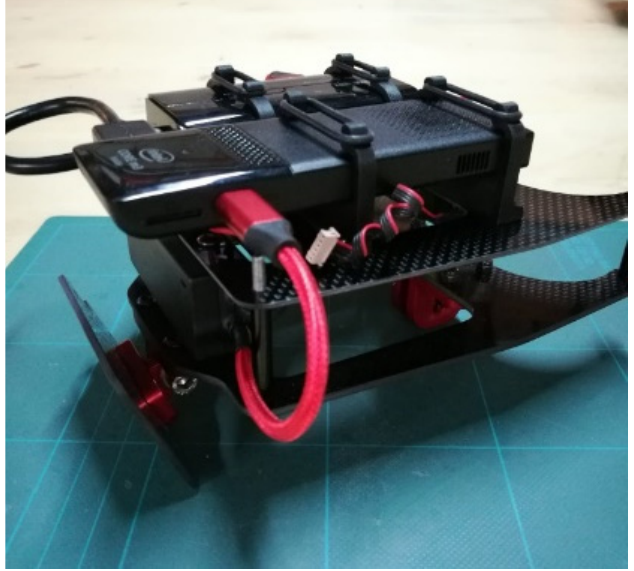
Figure 2. Customized mechanical support housing the onboard CPU and the USB